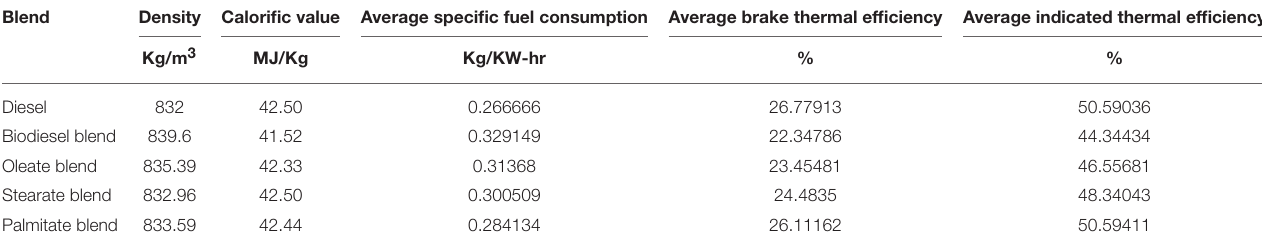
TABLE 5 | Average specific fuel consumption, brake and indicated thermal efficiency of diesel and blend samples.